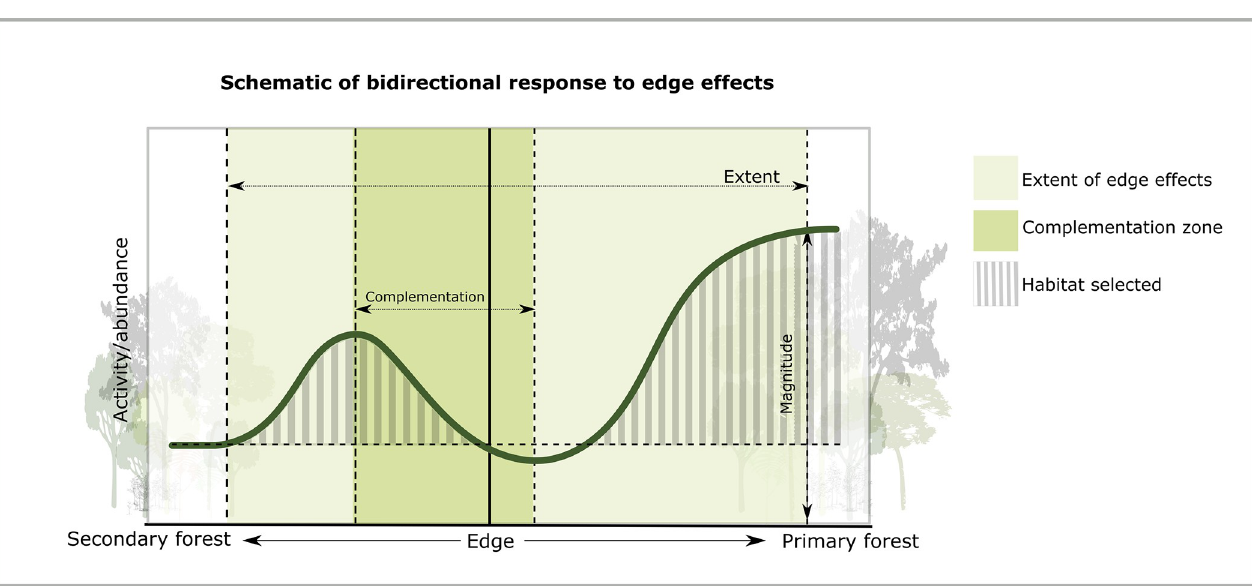
Fig 5. Schematic of bidirectional response to edge effects. A theoretical example of how activity/abundance may exhibit a bidirectional response to edge effects. The complementation zone would be the area between the first asymptotes from the edge in each habitat. The full extent of edge effects is observed at the second asymptotes from the edge in each habitat whereby activity